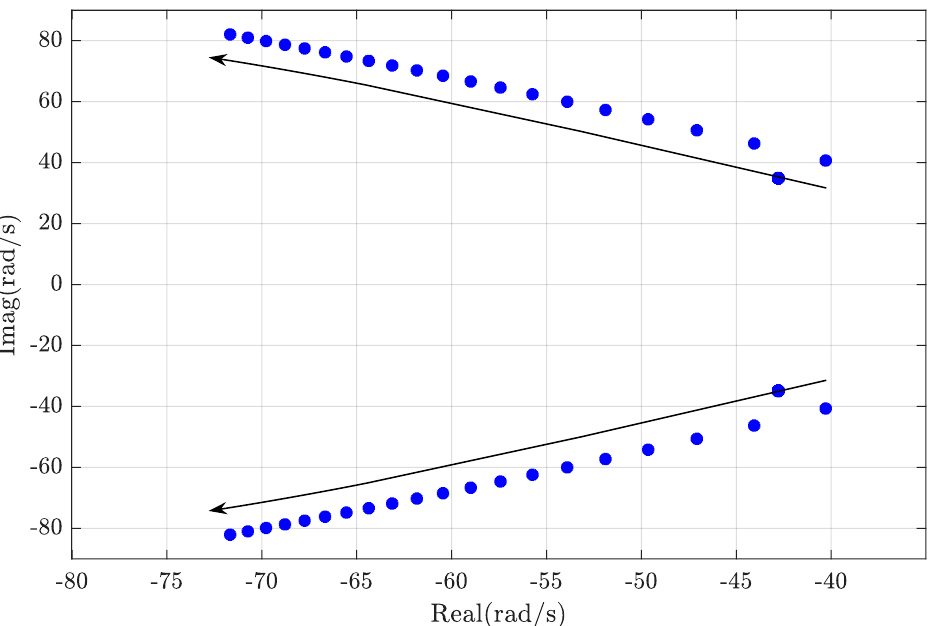
Figure 15. Replacement of dominant poles of the linearized PVSC system for variation of active power droop 0.01 < m d <